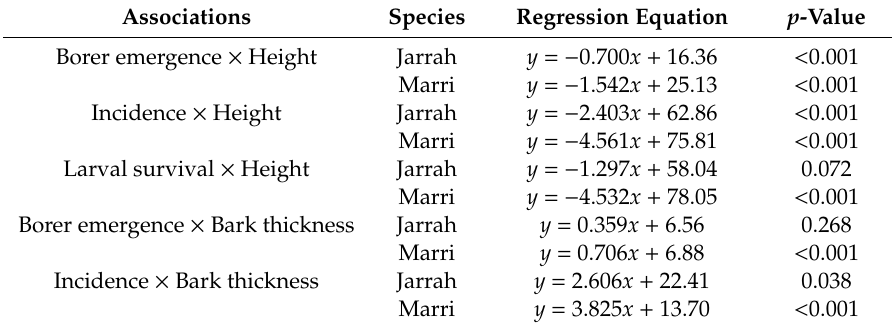
Table 2. Fitted models for borer emergence (m − 2 ), incidence of larval galleries (%) and larval survival (%) of the Australian eucalyptus longhorned borer Phoracantha semipunctata as a function of height (m), diameter (cm) and bark thickness (mm) of jarrah ( Eucalyptus marginata ) and marri ( Corymbia calophylla ) trees in the Northern Jarrah Forest (NJF), Southwestern Australia. Associations were analysed by least squares regression. Associations Species Regression Equation p -Value Borer emergence × Height Jarrah y = − 0.700 x + 16.36 < 0.001 Marri y = − 1.542 x + 25.13 < 0.001 Incidence × Height Jarrah y = − 2.403 x + 62.86 < 0.001 Marri y = − 4.561 x + 75.81 < 0.001 Larval survival × Height Jarrah y = − 1.297 x + 58.04 0.072 Marri y = − 4.532 x + 78.05 < 0.001 Borer emergence × Bark thickness Jarrah y = 0.359 x + 6.56 0.268 Marri y = 0.706 x + 6.88 < 0.001 Incidence × Bark thickness Jarrah y = 2.606 x + 22.41 0.038 Marri y = 3.825 x + 13.70 <